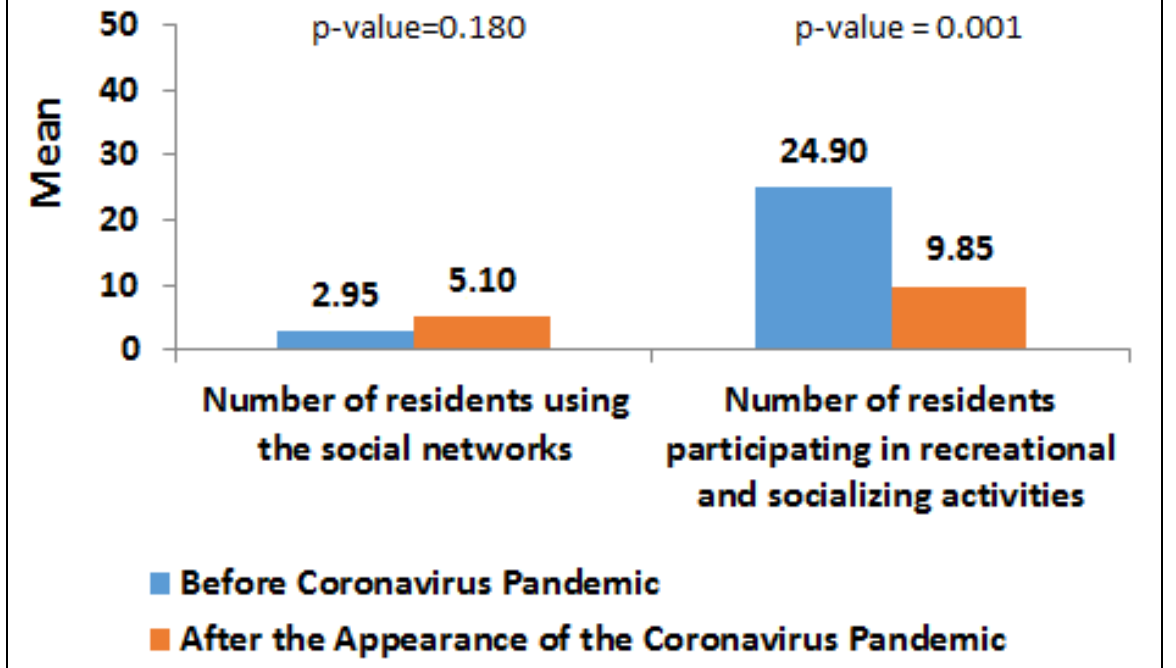
Figure 5. The number of residents using social networks and the number of residents participating in recreational and socializing activities before and after the COVID-19 pandemic.